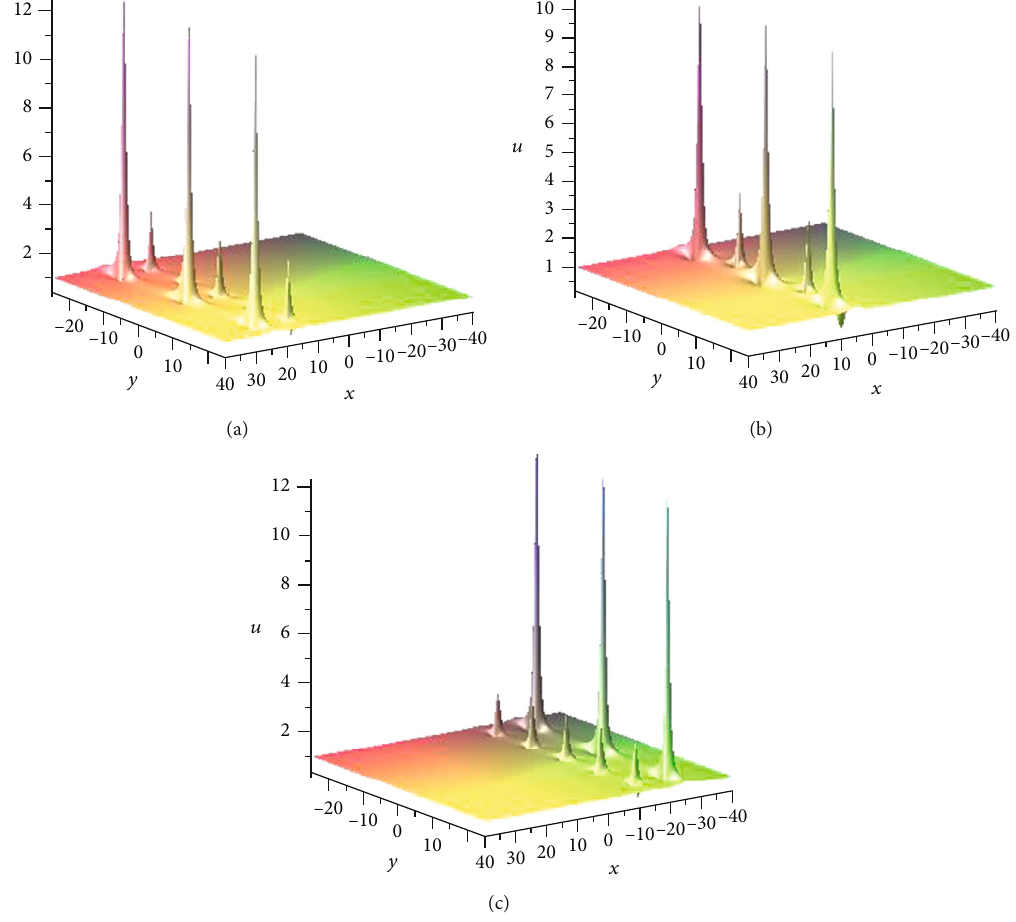
> 0 at di ff erent times: (a) n = − 30 , (b) n = − 8 , and (c) n = 35 1 L 2